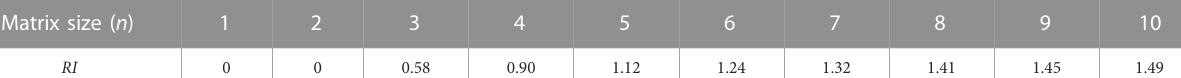
TABLE 3 Saaty ’ s random index values ( RI ) (Saaty and Kearns, 1985). Matrix size ( n